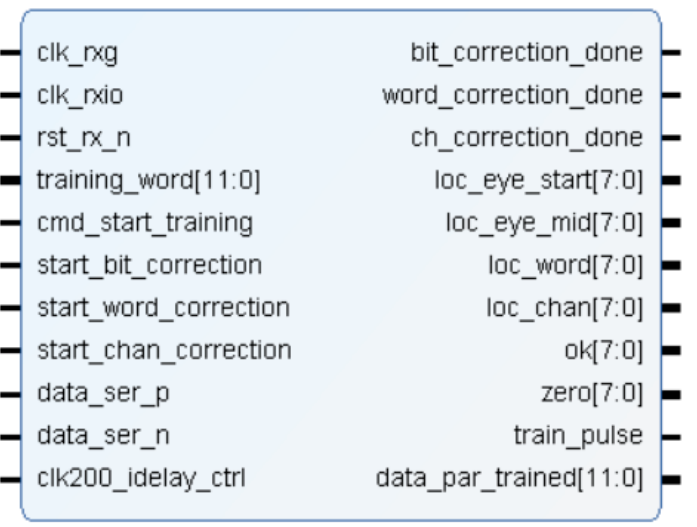
Figure 11. Module interface of training_one_channel.v.